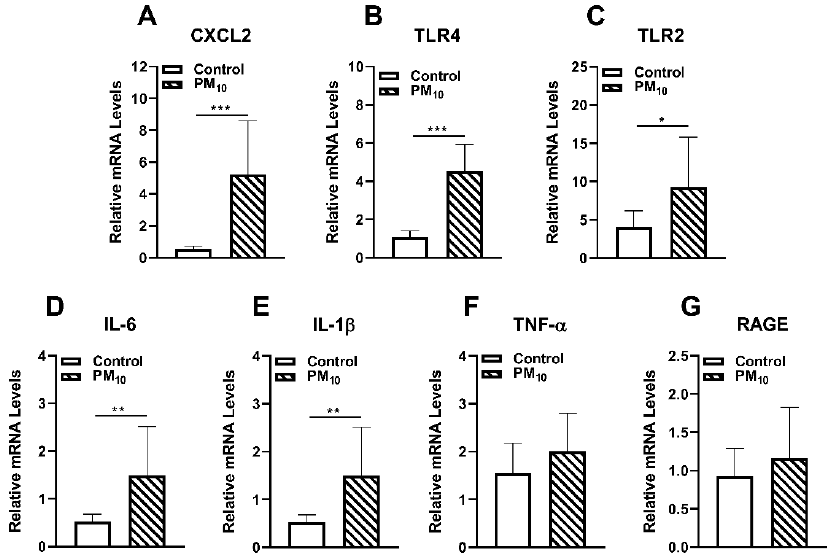
Figure 3. Effects of PM 10 on innate immunity. RT-PCR showed significantly elevated mRNA levels in PM 10 vs. control exposed corneas for chemokine CXCL2 ( A ), TLR4 ( B ), TLR2 ( C ), IL-6 ( D ), IL-1 β ( E ) only but not TNF- α ( F ) and RAGE ( G ) after 2 weeks exposure. Data are expressed as mean + SD. (* p < 0.05, ** p < 0.01, *** p < 0.001, n = 5/group).